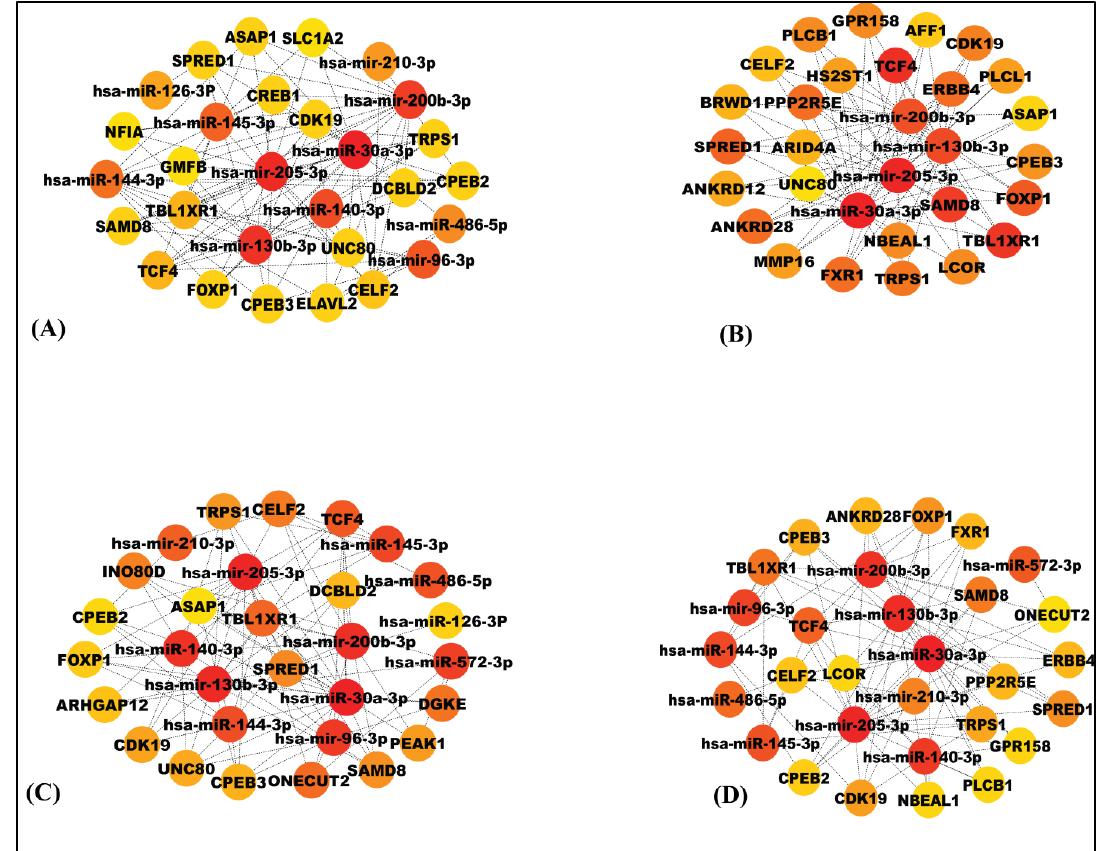
Figure 4. Significant modules and the top 30 ranked genes/miRNAs in the network on the basis of ( A ) Degree, ( B ) Closeness, ( C ) Betweenness and ( D ) Stress. The top 30 ranked genes/miRNAs in the network indicate both gene and miRNA. Red indicates the highest rank, whereas yellow indicates the lowest rank. Based on these modules, nine key genes and four miRNAs were found to be common in all modules and were considered as significant hub nodes.